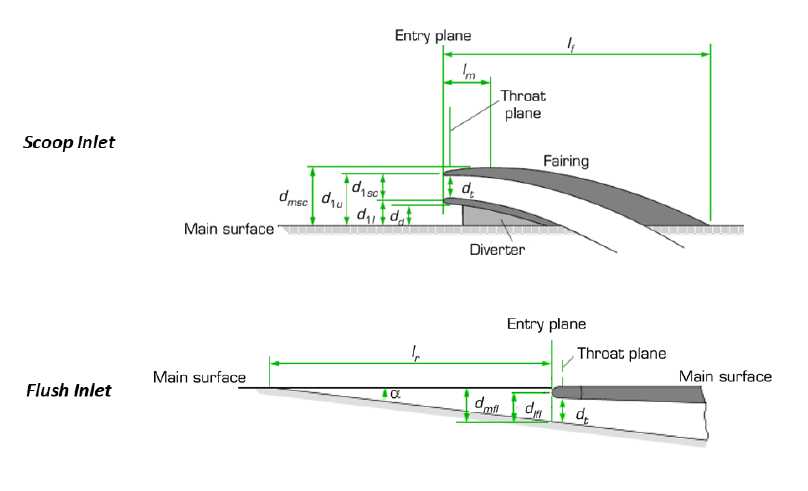
Figure 5. Air inlets geometry adapted from